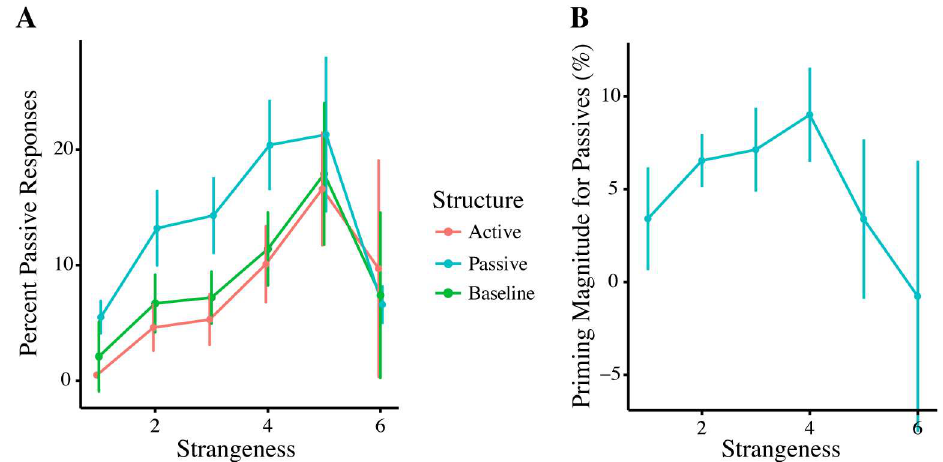
Fig 6. Passive Repetition per Strangeness. A. Percent of passive responses after each prime type B. Passive primingmagnitude(the percent of passive responses after a passive prime after baselinecorrection) shows an inverted U-shapedcurve as a function of Strangeness . Error bars reflect standard